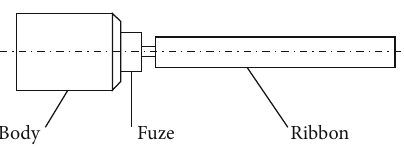
Figure 3: The structure of a submunition.